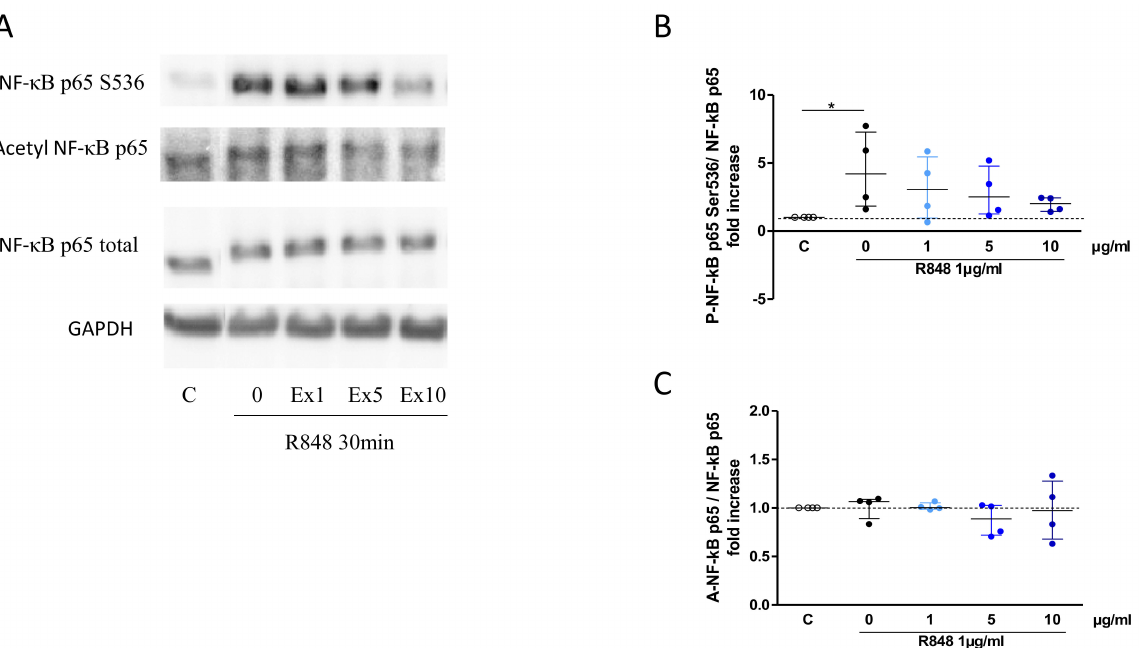
Figure 5. Inhibitory effect of S. miltiorrhiza extract (Ex; 1, 5 or 10 µ g/mL) on NF- κ B activation following incubation with R848 (1 µ g/mL) for 30 min. Representative western blot ( A ), with quantification data for phosphorylation of p65NF- κ B S536 ( B ) and acetylation of p65NF- κ B K310 ( C ). GAPDH was used as loading control ( n = 4; * p <